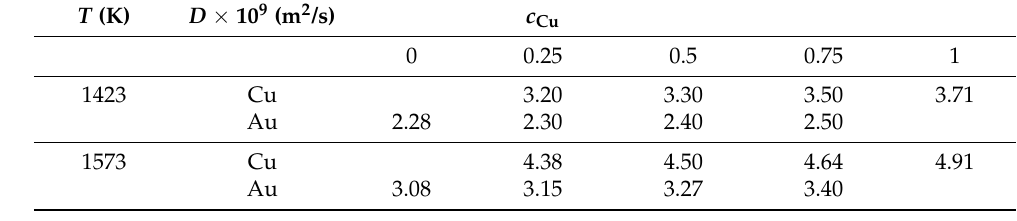
Table 2. Self-diffusion coefficients of Cu and Au in liquid Cu-Au alloy at T = 1423 K and T = 1573 K.